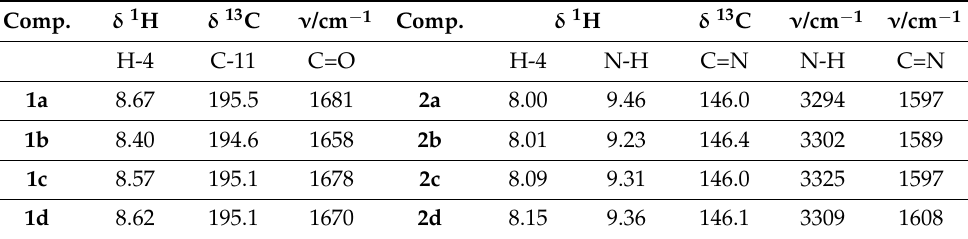
Table 1. Selected 1 H, 13 C NMR ( δ = ppm, DMSO-d6) and IR ( ν = cm − 1 ) spectroscopic data for compounds 1a – d and 2a – d .